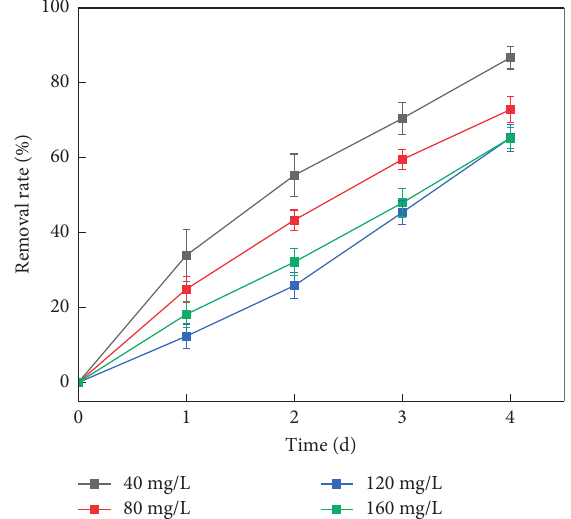
Figure 3: Removal efficiency of CBZ with different initial con- centrations by ANFICV.